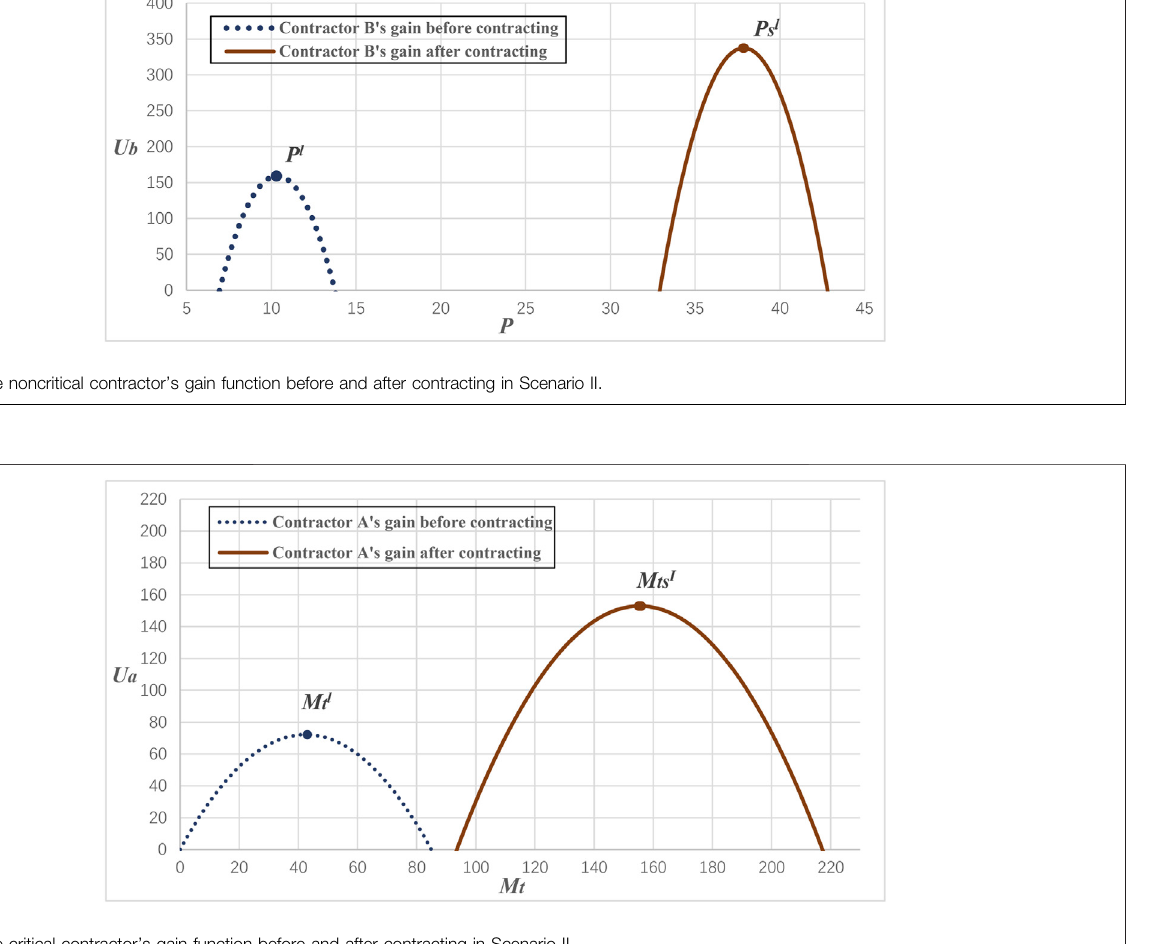
FIGURE 7 | The critical contractor ’ s gain function before and after contracting in Scenario II.